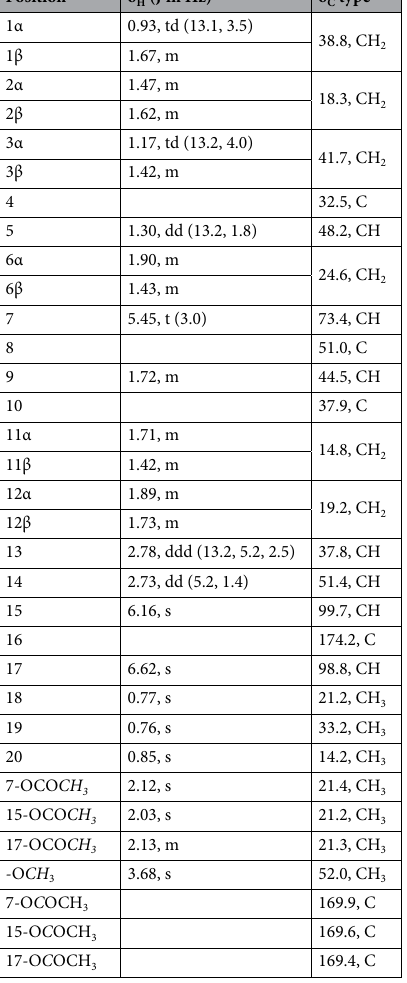
Table 1. NMR Data for compound 1 in CDCl 3